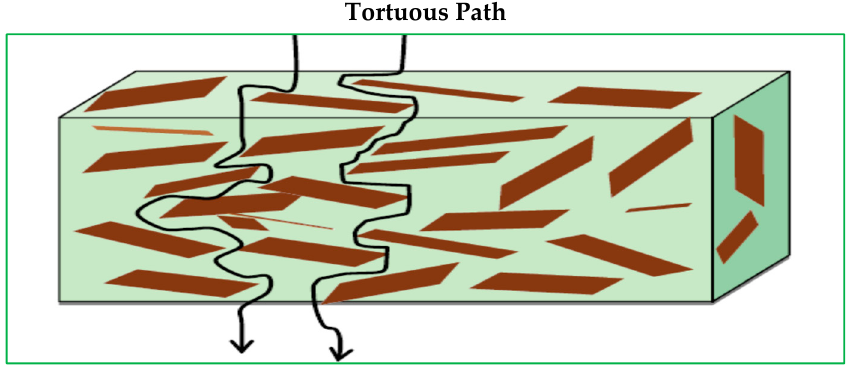
Figure 14. Schematic representation of the mechanism tortuous of improved barrier mechanism by the addition of clay platelets. Table 5. Summary studies on water permeability of polymer–clay